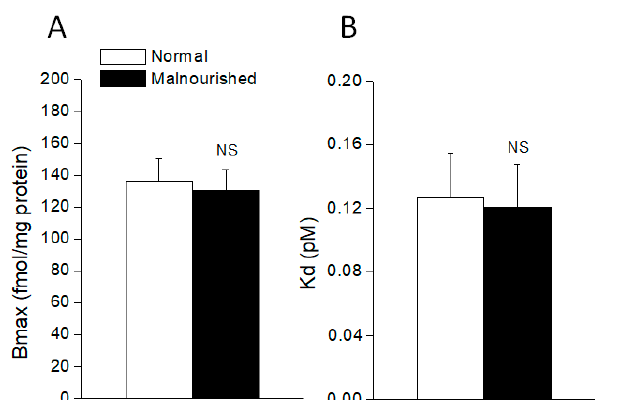
Figure 5. The number of total α 1 -adrenoceptor binding sites (Bmax) ( A ) and dissociation constant (Kd) ( B ) in the hypothalamus of normal and malnourished rats, as revealed by [ 3 H]-prazosin binding assay. Values are the mean ± SEM of six eutrophics and six prenatally undernourished rats of 40 days of age, the difference between the two groups being not statistically significant (NS: not significant; for Bmax comparison p = 0.7730, t = 0.2964; for Kd comparison p = 0.8805, t = 0.1543; two-tailed unpaired Student’s t -test).